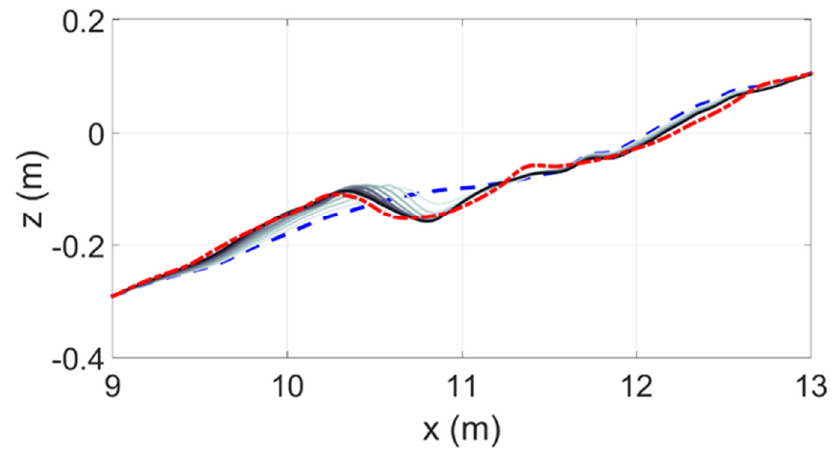
Figure 8. Comparison between the modelled (thick black) and observed mean beach (dashed red line) profile when equilibrium is reached at t = 22 h. The initial (dashed blue) and intermediate modelled (thin grey, in different shades) profiles are also plotted at 2 h intervals.